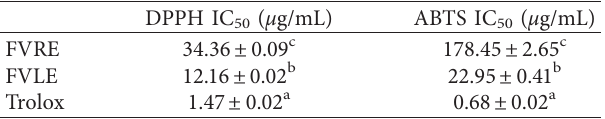
The data are the mean of three determinations ± standard error. Values in the same column not sharing a common letter (a to c) differ significantly at p < 0 .